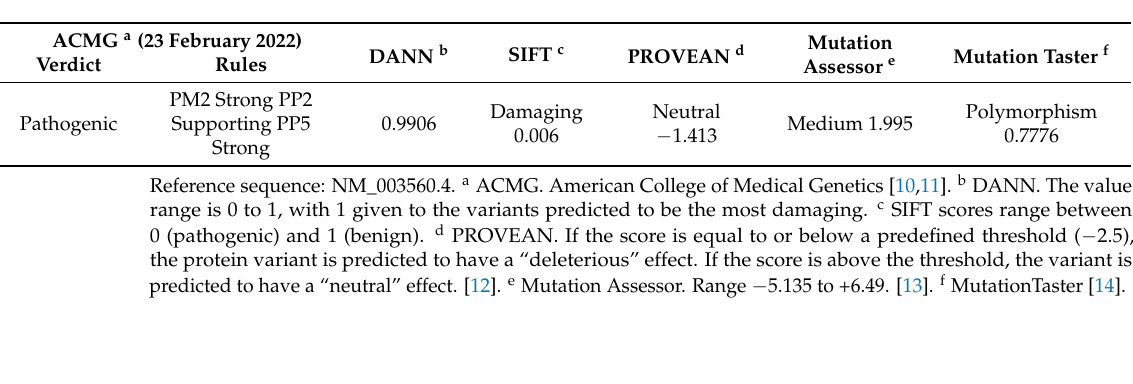
Table 1. Pathogenicity Predictors for the PLA2G6 variant